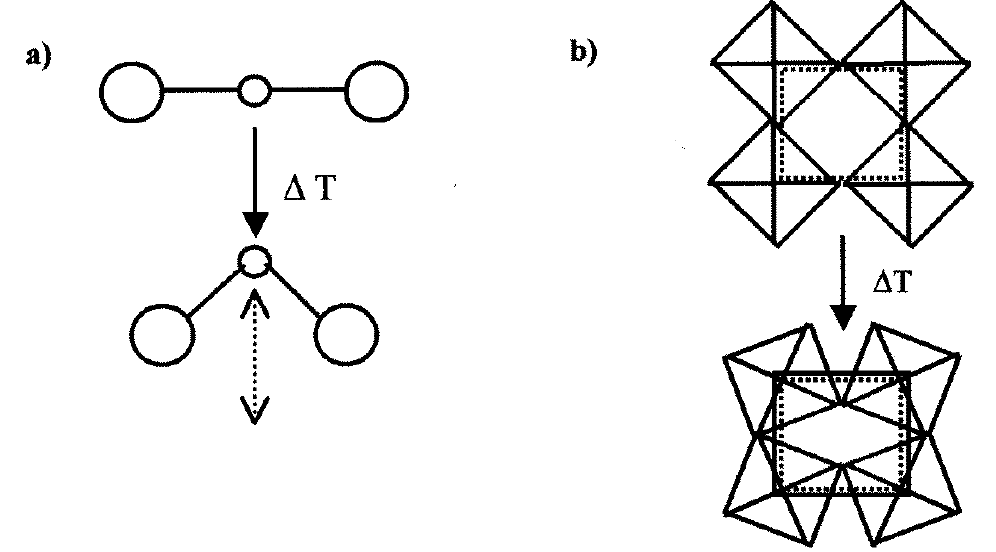
Figure 1. The mechanism of negative thermal expansion due to transverse atomic vibrations: ( a ) transverse motion of an oxygen atom in an M–O–M linkage; and ( b ) cooperative rocking of polyhedra causing a decrease in average metal-metal distances. The squares correspond to the locations of the metal atoms before (solid) and after (dotted)